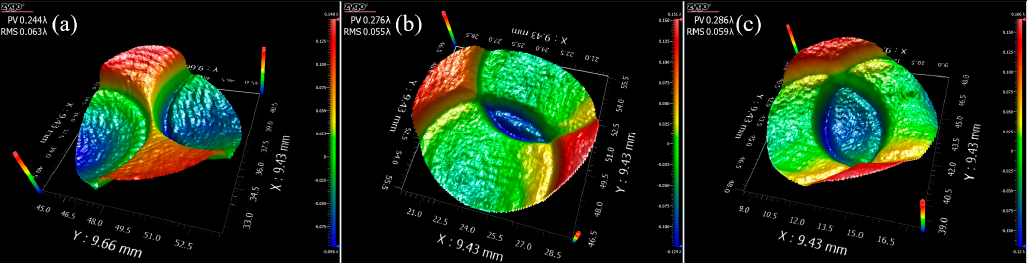
Figure 9. The material removal distribution under different overlap ratios: ( a ) center distance = 8.5 mm, ( b ) center distance = 6.5 mm, and ( c ) center distance = 4.5 mm (time = 300 s, amplitude = 40 μ m, gap = 0.1 mm).